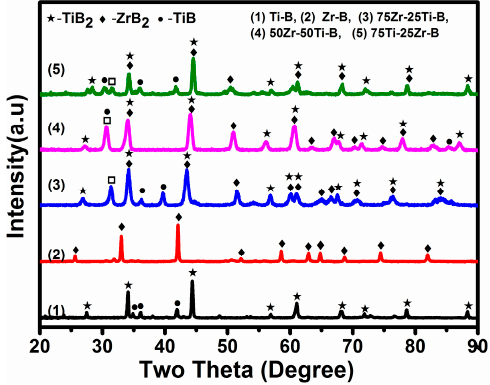
Figure 5. XRD of RSPSed samples.